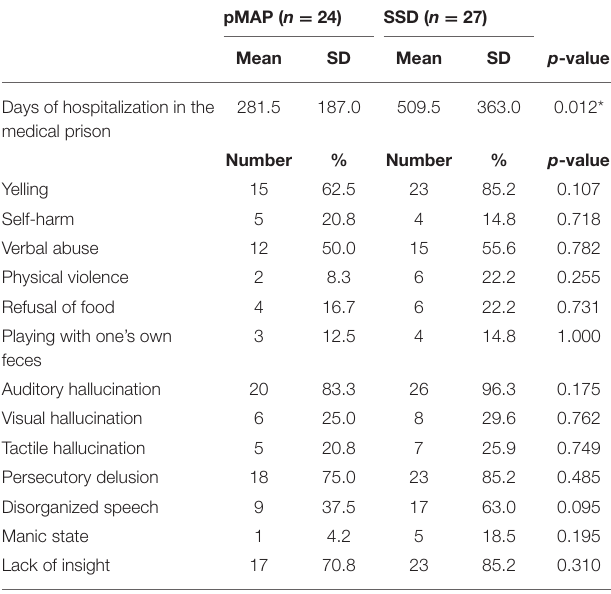
TABLE 2 | Behavioral problems and clinical symptoms of pMAP and SSD patients in the medical